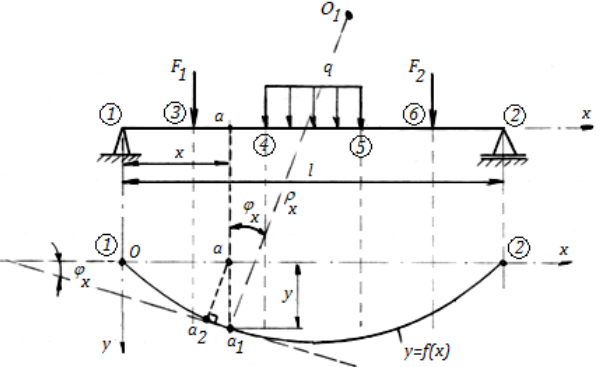
Figure 1. Plane deformation of a straight beam subjected to simple bending [1].